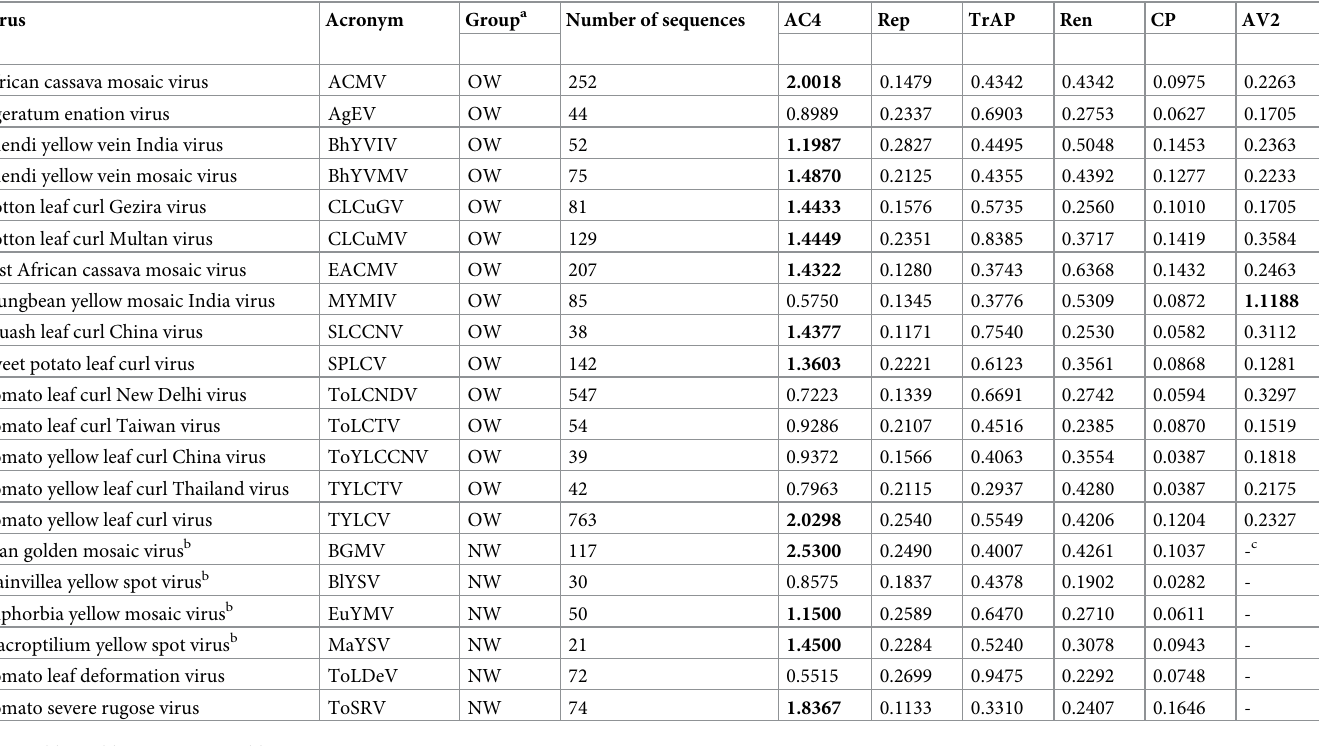
Table 3. Nonsynonymous to synonymous substitution ratios (dN/dS) calculated for OW and NW begomoviruses.